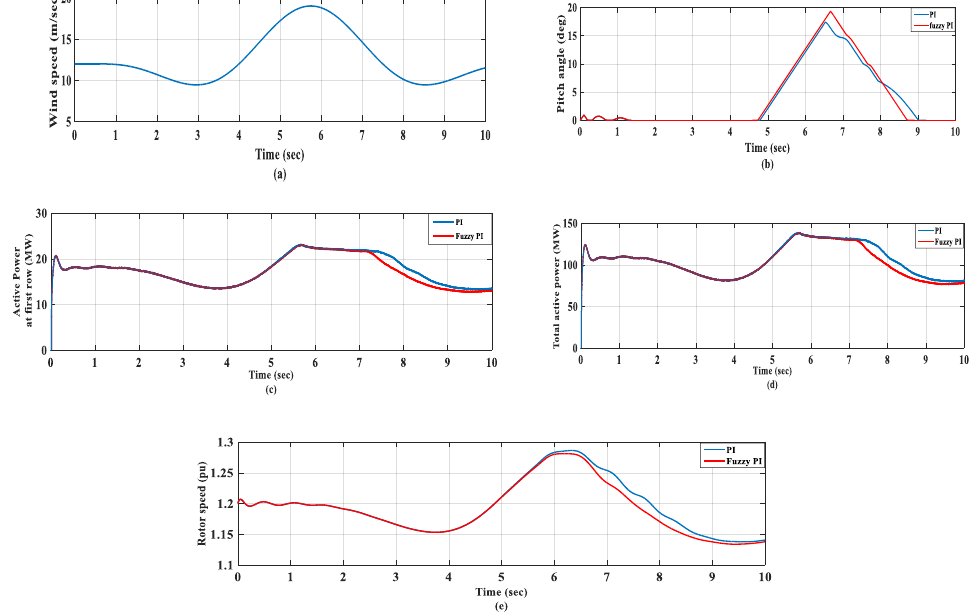
Figure 13. System response during extreme wind speed: ( a ) wind speed, ( b ) pitch angle, ( c ) active power of first row, ( d ) total active power, ( e ) rotor speed.